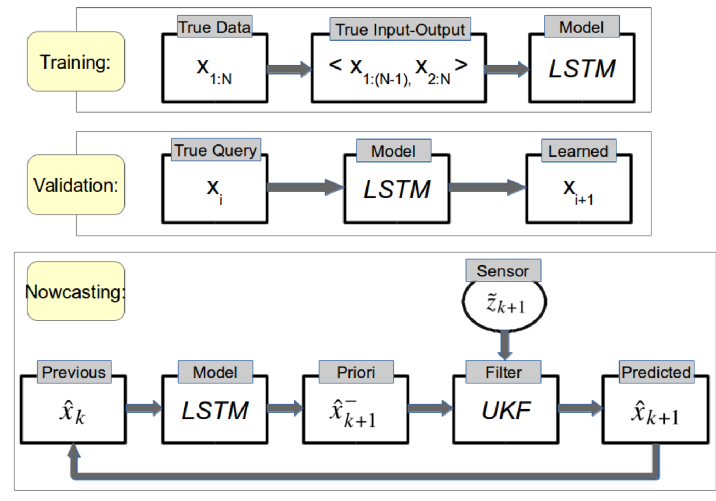
Figure 6. Overview of the UKF-aided LSTM method